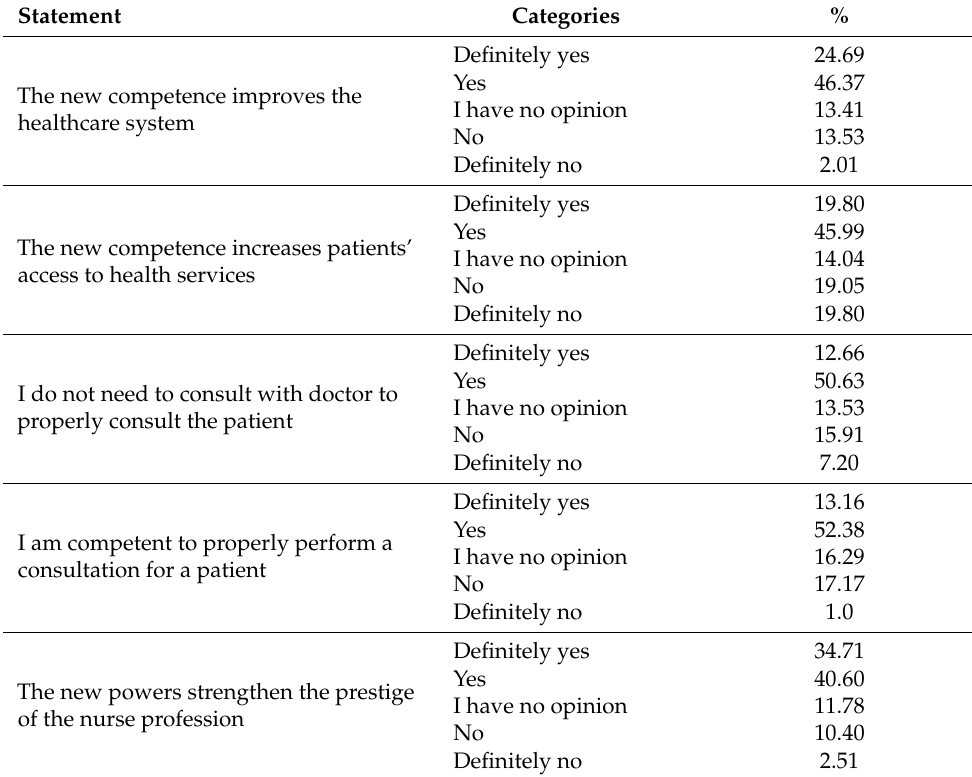
Table 2. Nursing advice in nurses’